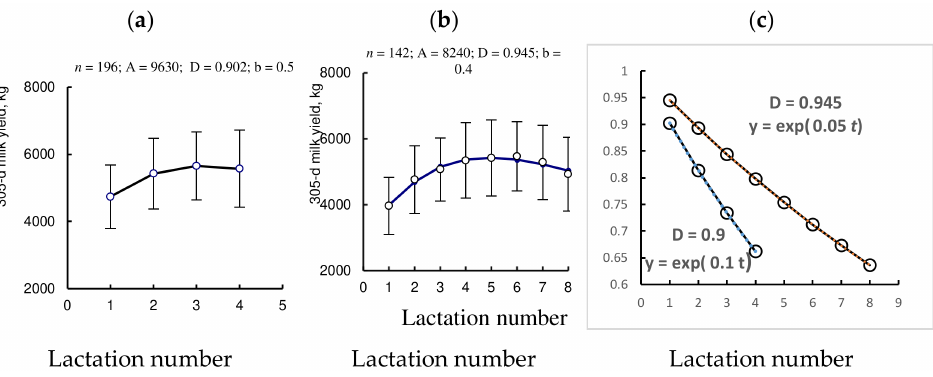
Figure 3. Age dynamics of 305 d milk yield ( a , b ) and degradation component D t ( c